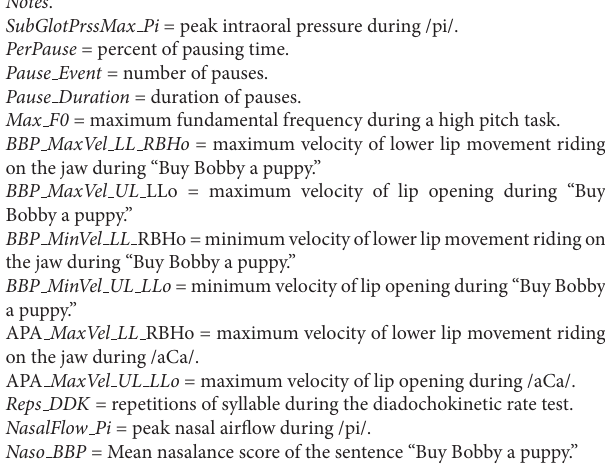
Figure 1: Scatter plot of the relation between speech intelligibility and speaking rate based on the SIT from all participants. The horizontal dashed line corresponds to 85% of intelligibility and the vertical dashed line corresponds to 120 WPM of speaking rate.